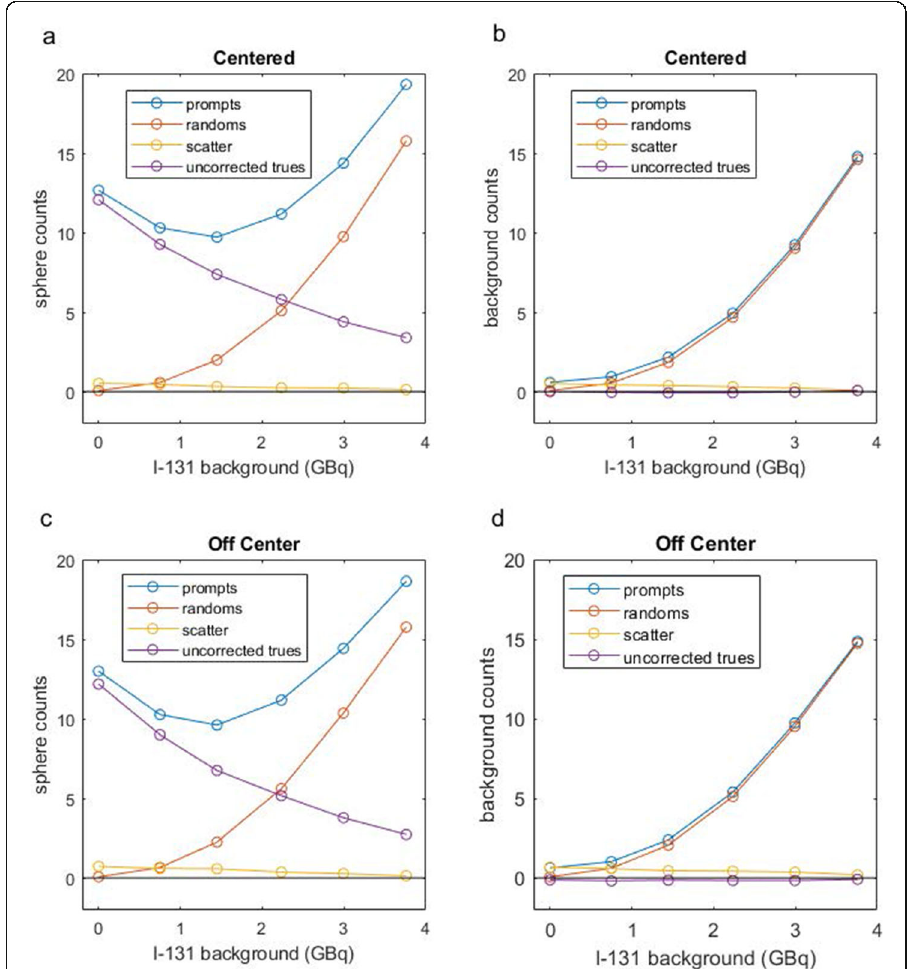
Fig. 3 Number of uncorrected true, scatter, and random events measured in a small VOI placed at the center of the 37-mm-diameter phantom sphere ( a , c ) and in the background ( b , d ) in projection space and for all angles as a function of increasing 131 I activity in the background for acquisitions with the phantom centered ( a , b ) and off-centered ( c , d